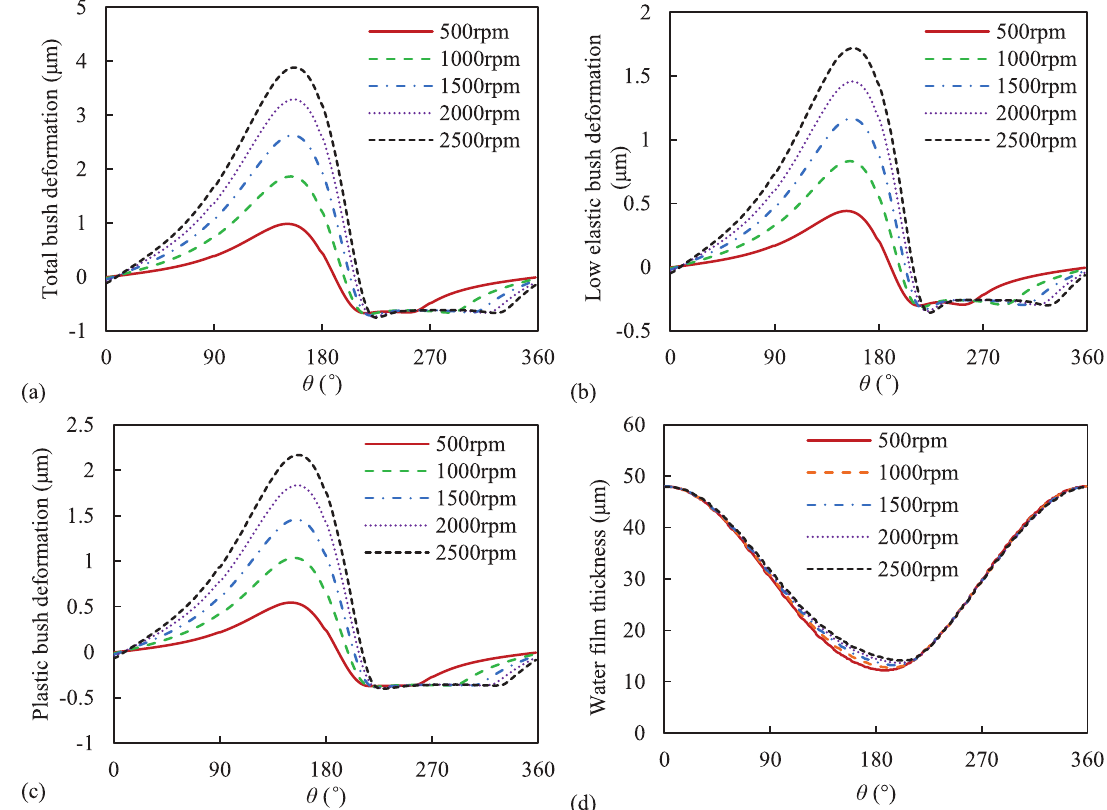
Fig. 10. (a) Bush total deformation distribution, (b) Deformation distribution of low elastic under-layer bush, (c) Deformation distribution of plastic layer bush, (d) Water fi lm thickness distribution for different rotational speed ( e =0.6, t 1 = t 2 =5 mm, E 1 = 1000MPa, E 2 =400